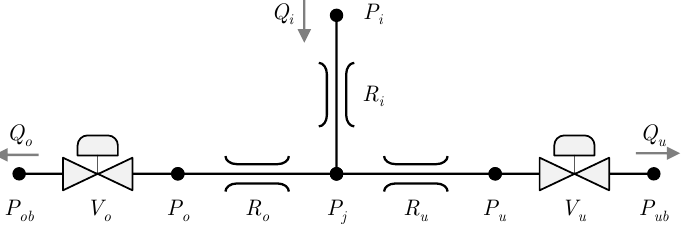
Figure 3. Hydrocyclone mathematically decomposed as simplified pressure drops. This figure is from